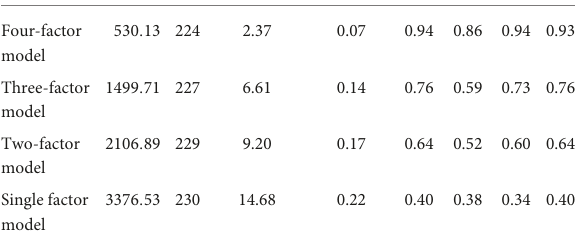
TABLE 2 Confirmatory factor analysis for discriminant